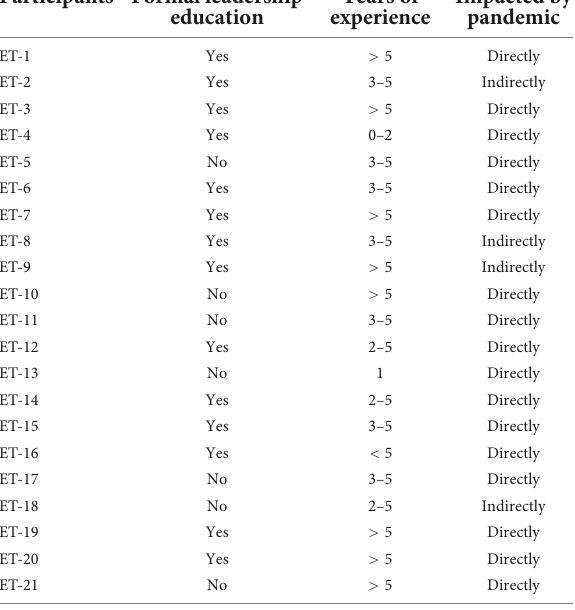
TABLE 1 Characteristics of the participating employees from the tourism industry.